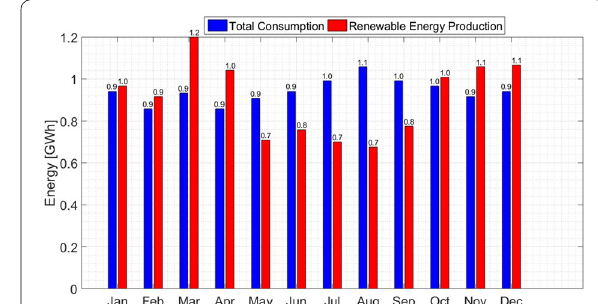
Fig. 18 Annual wind energy production on Flores island